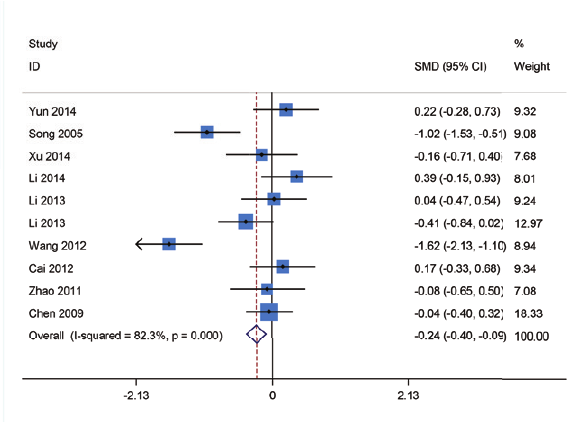
Figure 6: Forest plot of tripterygium glycoside-related toxicity for tripterygium glycosides in treatment of stage IV diabetic nephropa- thy. (The squares and horizontal lines demonstrate the study-speci- fic OR and 95% CI. The area of the squares reflects the study specific weight (inverse of the variance). The diamond represents the pooled OR and 95%